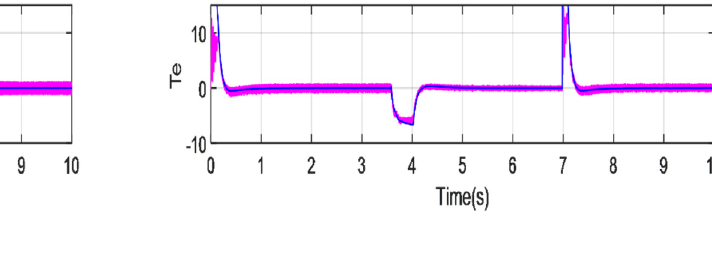
Figure 19. Speed response: ( a ) conventional inverter; ( b ) five-level inverter.